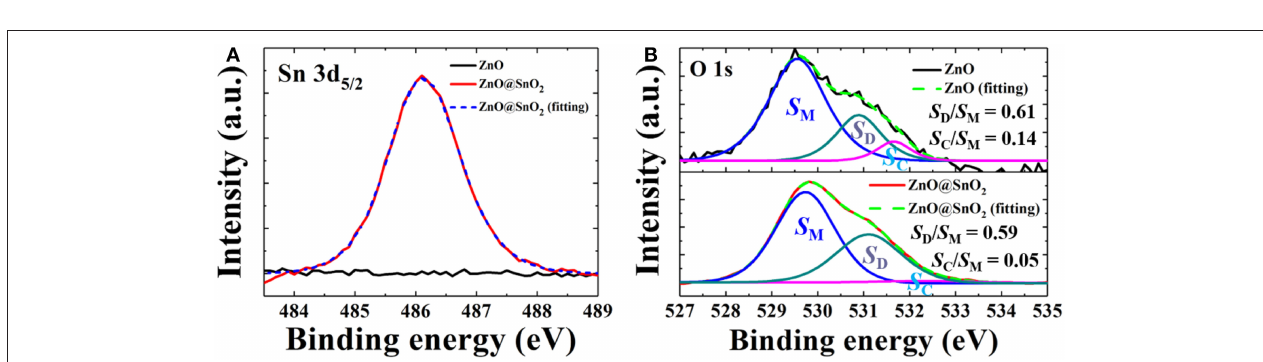
FIGURE 2 | XPS spectra of ZnO NWs and ZnO@SnO 2 NWs on glass: (A) Sn 3d and (B) O 1s with three resolved O bonding components (blue, green and pink lines).